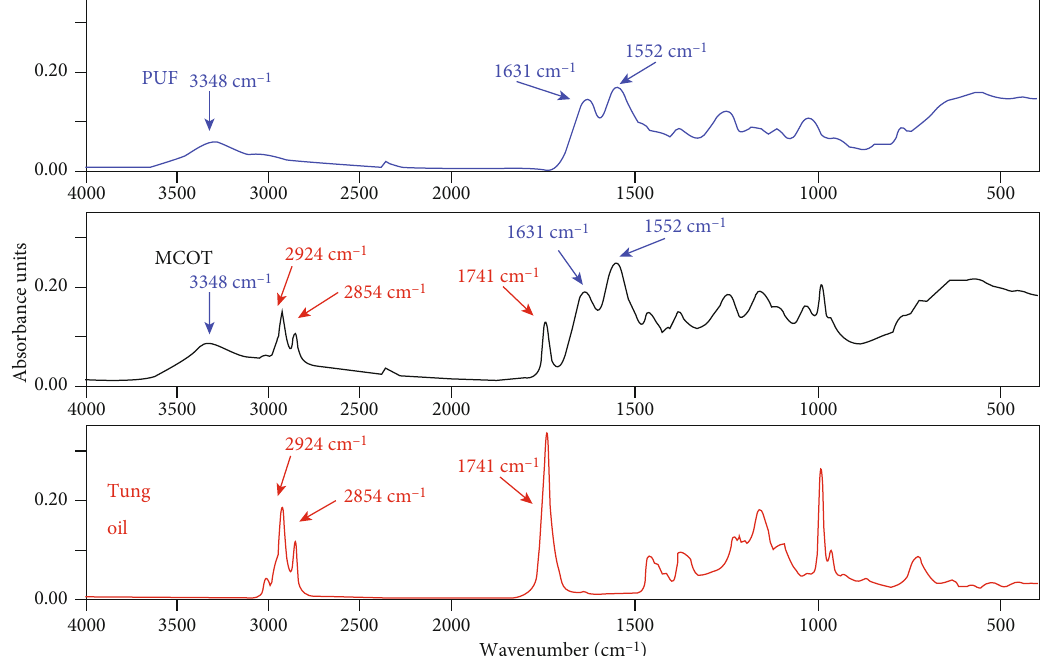
Figure 4: FTIR spectra of the wall material (poly(urea-formaldehyde)), the core material (tung oil), and the burst microcapsules.